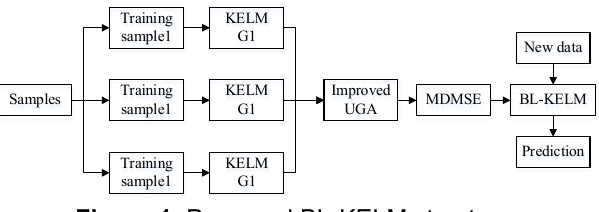
Figure 1. Proposed BL-KELM